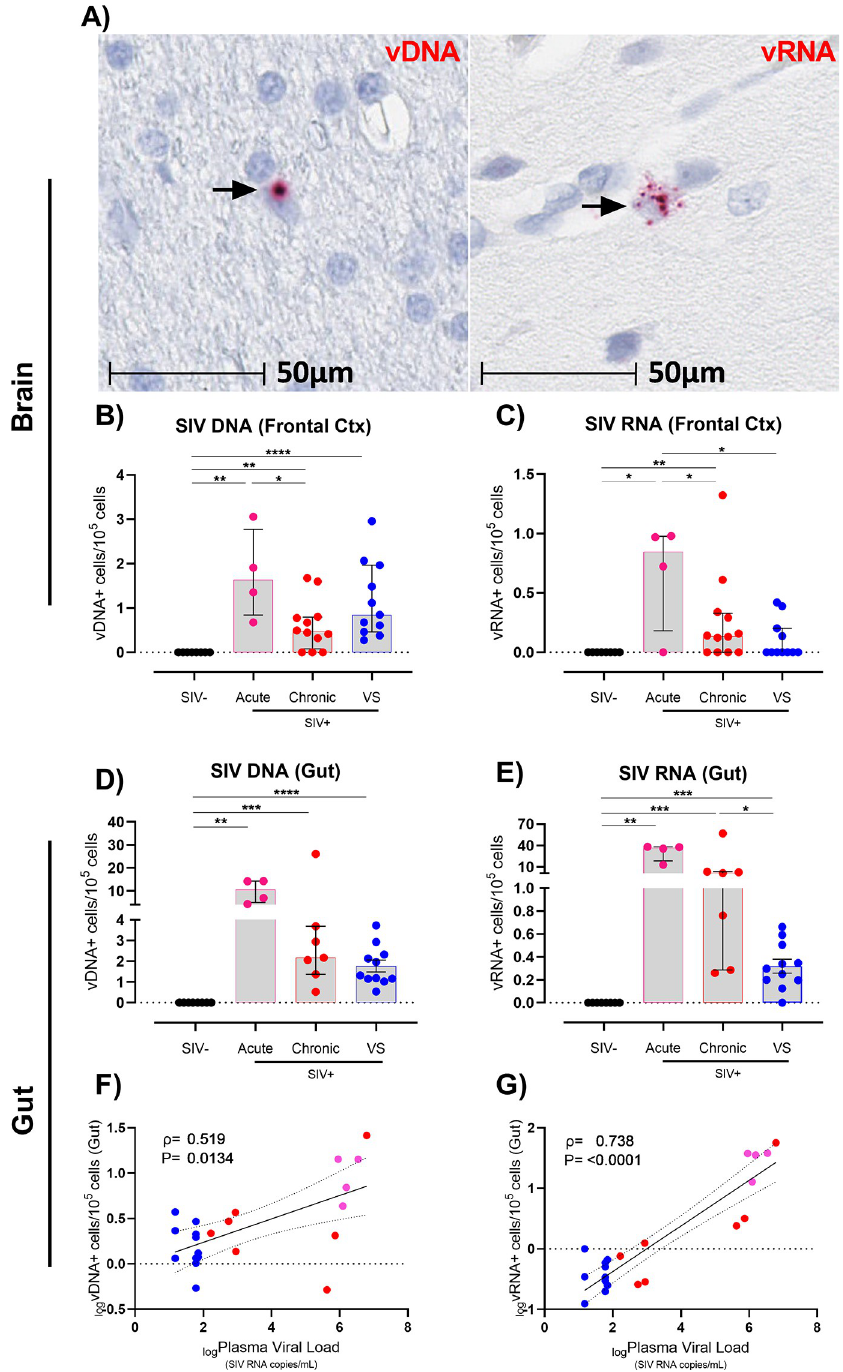
Fig 1. Frequency of vDNA and vRNA cells in frontal cortex and gut tissue from viremic and virally suppressed SIV+ rhesus macaques. (A) Representative images of brain cells harbouring vDNA or vRNA (black arrows) detected via DNAscope and RNAscope analysis in frontal cortex brain tissue from chronic SIV+ RMs. Images shown at x60 magnification. Frequency of vDNA+ cells or vRNA+ cells in the (B and C) brain or (D and E) gut tissue. Comparisons made using Mann-Whitney U test, ( * P < 0.05, ** P < 0.01, *** P < 0.001). Median and interquartile ranges shown. (F and G) Correlative analysis of plasma viral load vs (F) vDNA+ or (G) vRNA+ cells in the gut (Spearman correlation, P value and Spearman ρ shown). SIV+ virally suppressed RMs (blue circles), SIV+ viremic RMs (red circles), SIV+ acute RMs (pink circles).